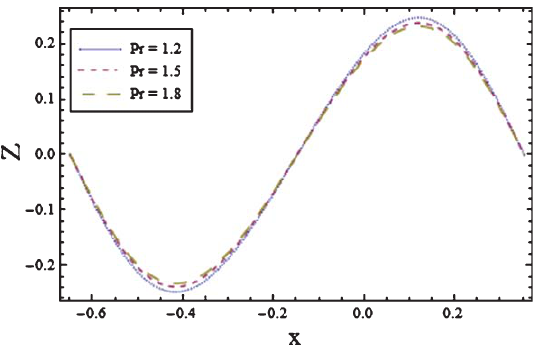
Fig. 19. Plot of heat transfer coefficient Z for various values of the Biot number γ 1 with (cid:15) = 0 . 1, t = 0 . 1 , Sc = 1 , Du = 2 , Sr = 2 , γ = 1 , Pr = 1 . 5 and γ = 8. 2